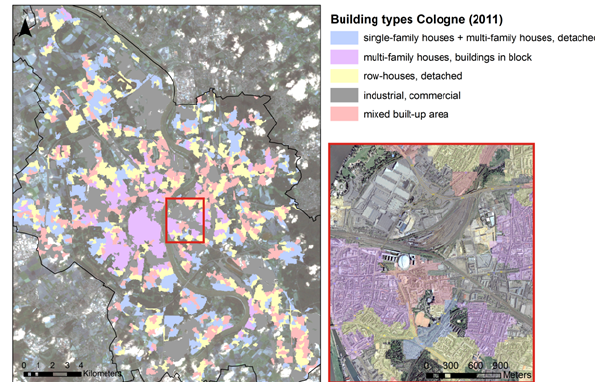
Figure 5. Building type stratification of the study area of Cologne: (a) superimposed on input Landsat image and (b) a magnification superimposed on Google Earth imagery.